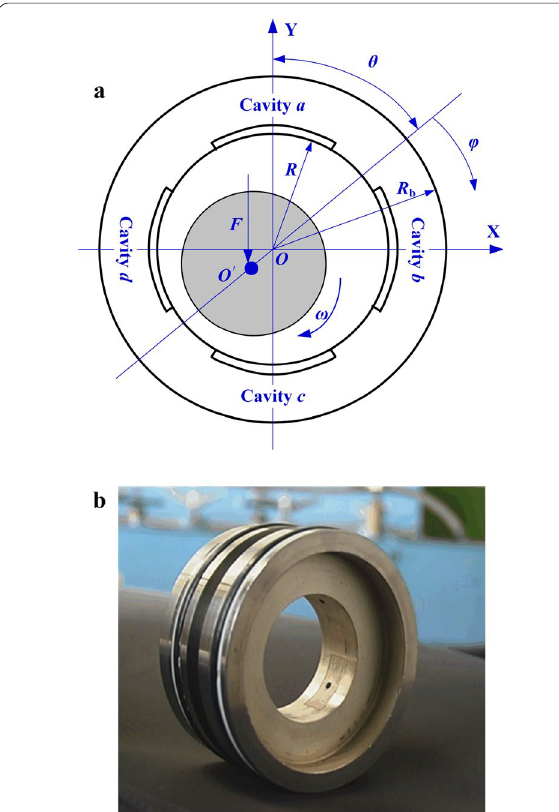
Figure 7 a Structural diagram of hybrid fluid-film bearing with four hydrostatic cavities, b photograph of the real bearing